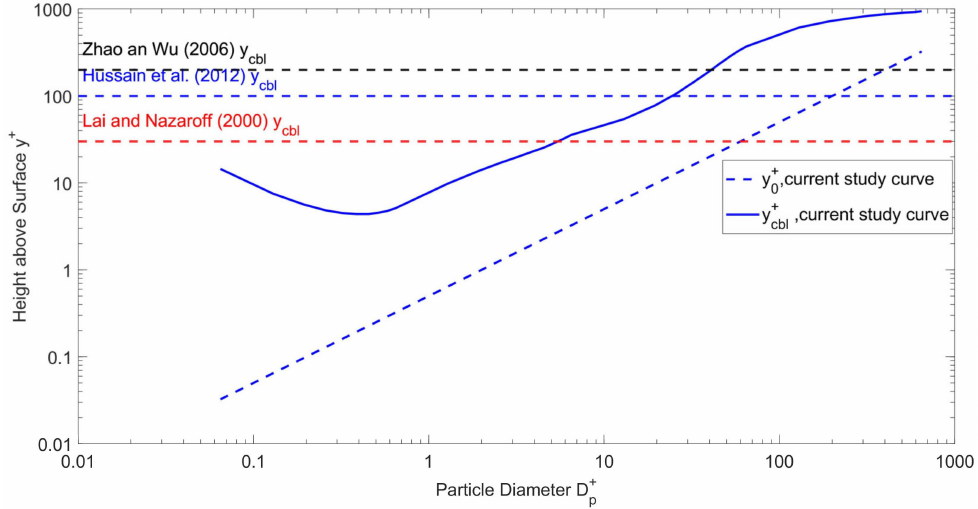
Figure 2. Illustration of the Variation of the concentration boundary layer height above the surface in dimensionless unit ( y + ) with the dimensionless particle diameter ( D + p ) for the current study. The horizontal dashed lines resemble the limit value for y + cbl used in the calculation by Zhao and Wu [19], Hussain et al. [15], and Lai and Nazaroff [18]. Friction velocity u* = 100 m/s, and number of subdivisions N = 1000